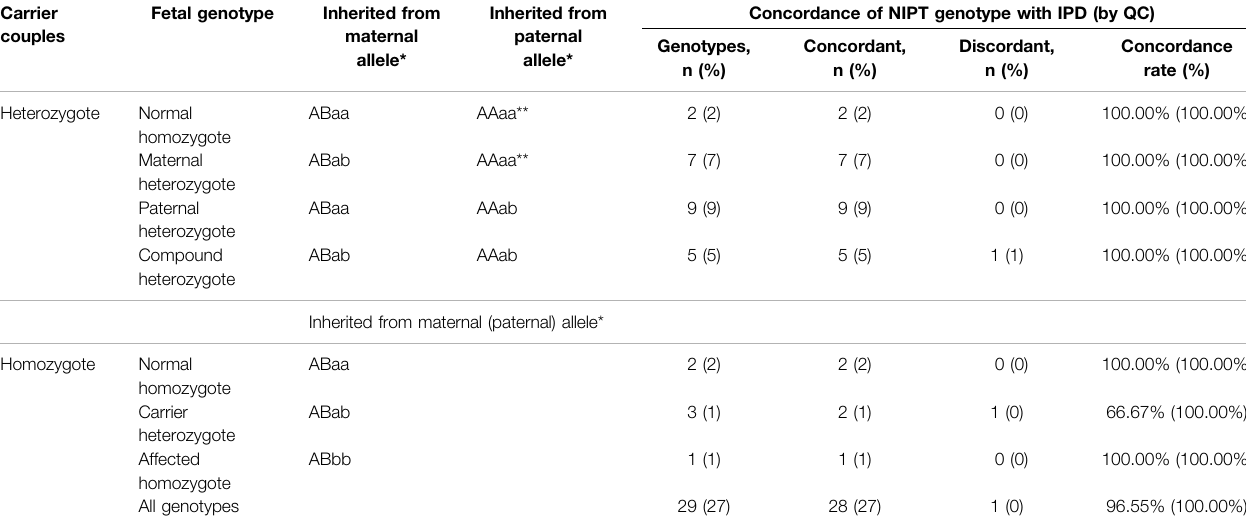
TABLE 1 | Genotype description deduced from the maternal – fetal genotype for the inherited maternal and paternal alleles. Carrier